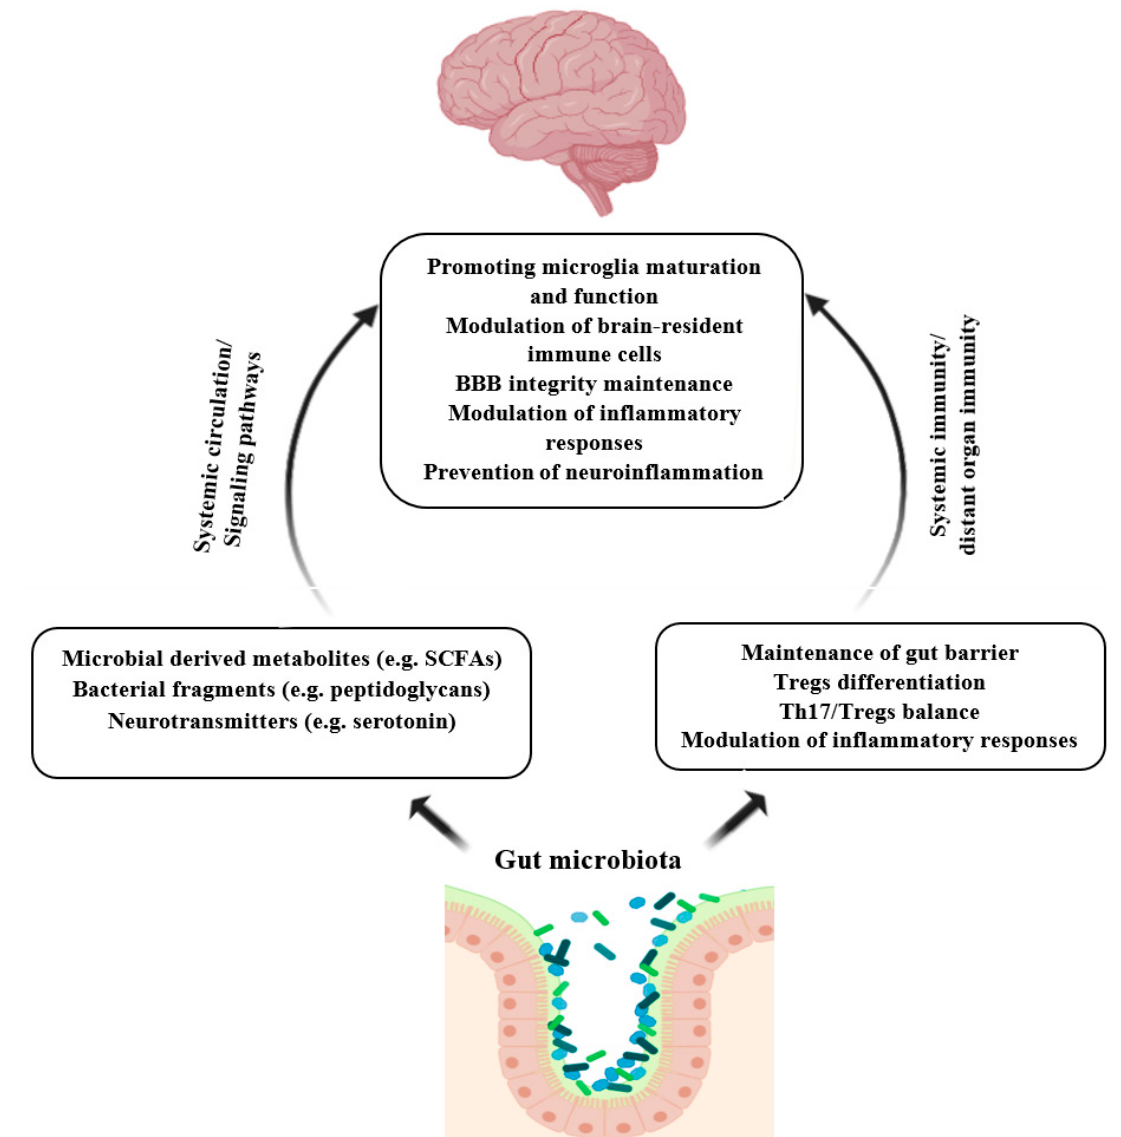
Figure 2. Role of gut microbiota in the prevention of neuroinflammation. Microbial products and metabolites can induce brain immunity indirectly by activating signaling pathways or directly through passing BBB. Gut microbiota regulates gut immunity hemostasis and modulates systemic immunity and brain immunity as well. Finally, gut commensal and their metabolites modulate microglia maturation and function, maintain BBB integrity, and prevent neuroinflammation. SCFAs: Short-chain fatty acids; Tregs; t regulatory cells; Th17: T-helper 17. Created with BioRender.com.